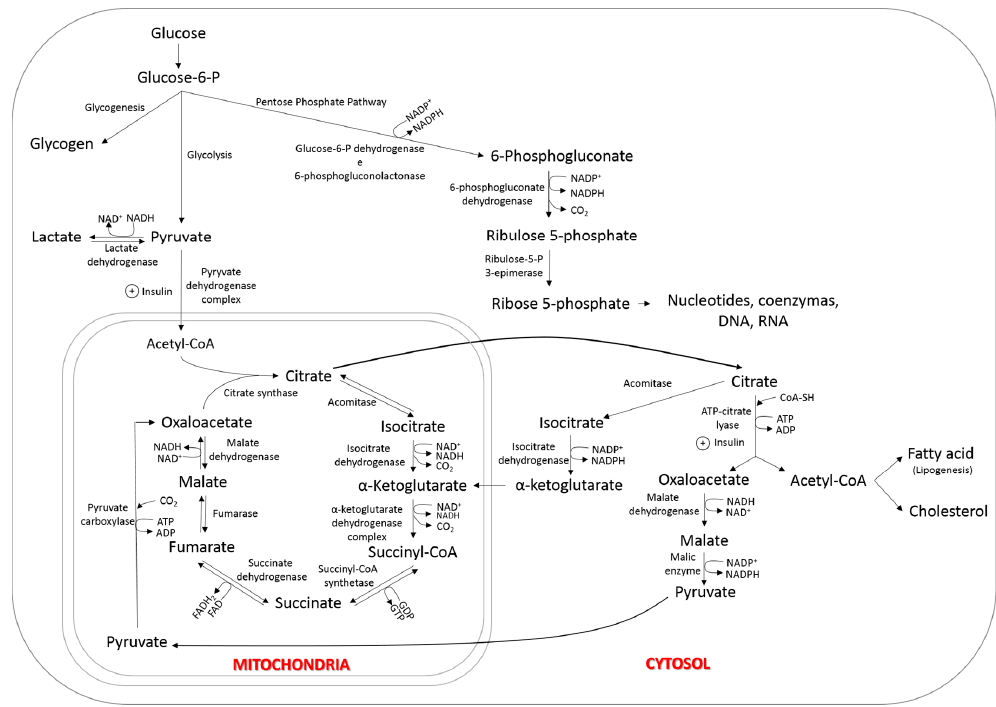
Figure 2. Synthesis of fatty acid from glucose in adipocytes. NAD + : nicotinamide adenine dinucleotide oxidized; NADH: nicotinamide adenine dinucleotide reduced; NADP + : nicotinamide adenine dinucleotide phosphate oxidized; NADPH: nicotinamide adenine dinucleotide phosphate reduced; CO 2 : carbon dioxide; CoA-SH: coenzyme A; ATP: adenosine triphosphate; ADP: adenosine diphosphate; DNA: deoxyribonucleic acid; RNA: ribonucleic acid; GTP: guanosine triphosphate; GDP: guanosine diphosphate; FAD: flavin adenine dinucleotide oxidized; FADH 2 : flavin adenine dinucleotide